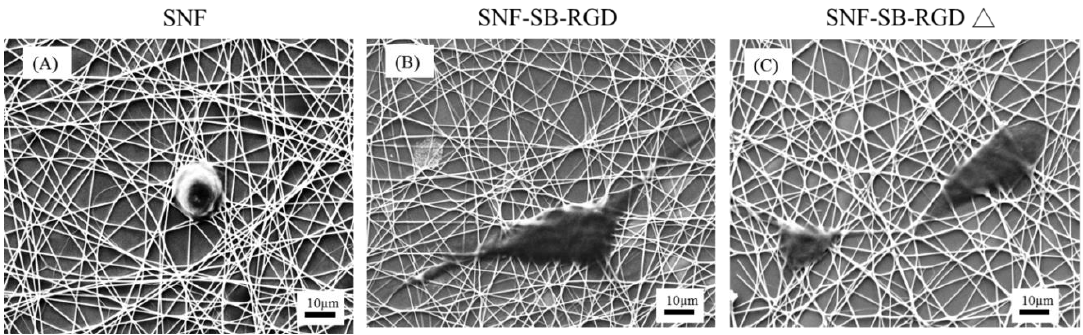
Figure 8. SEM images of PC12 cell differentiation on ( A ) SNF, ( B ) SNF-SB-RGD, ( C ) SNF-SB-RGD ∆ substrates at Day 5. The scale bars represent 10 μm.